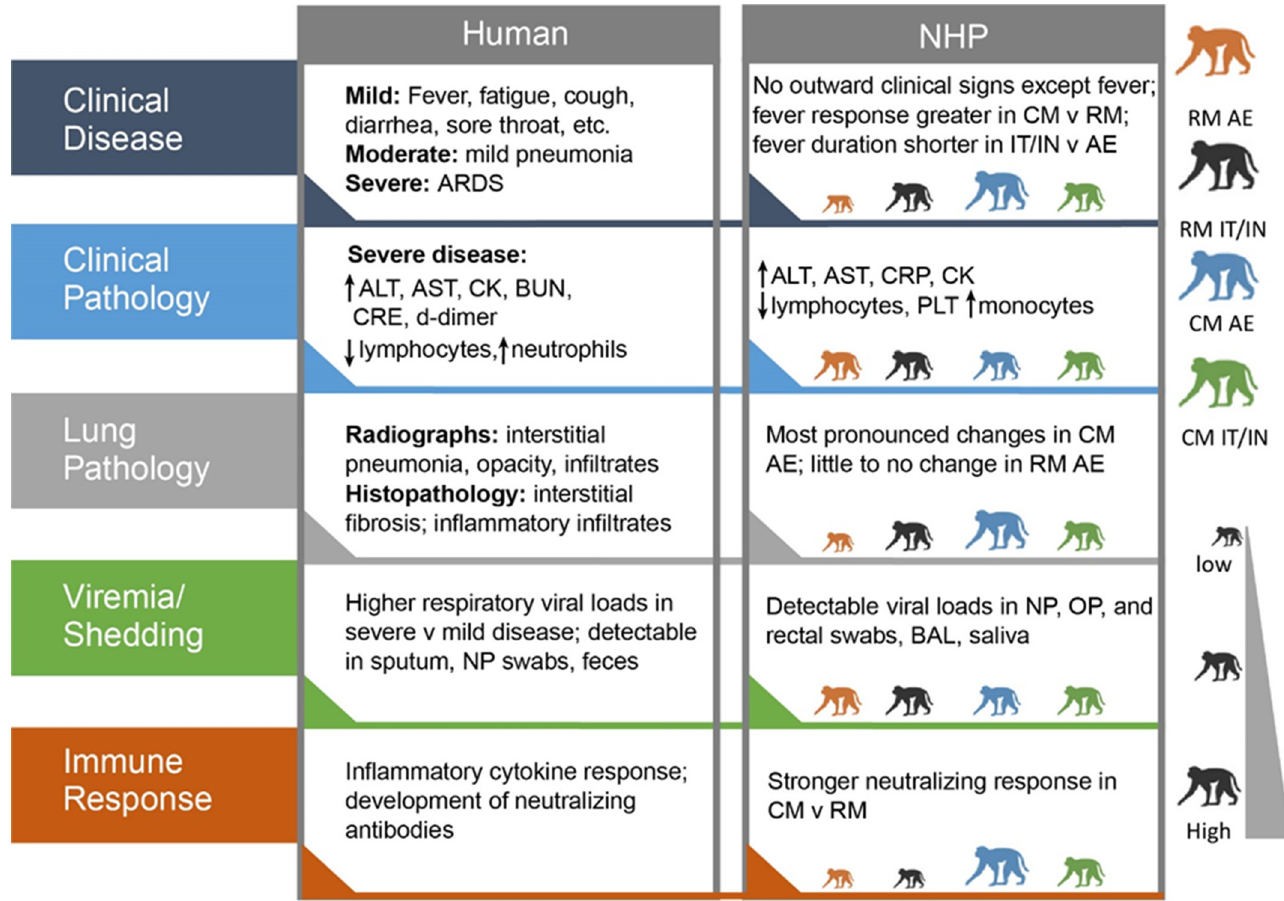
Figure 8. Comparison of human COVID-19 and SARS-CoV-2 disease in nonhuman primates (NHP). The size of the NHP shows the relative response for that group.